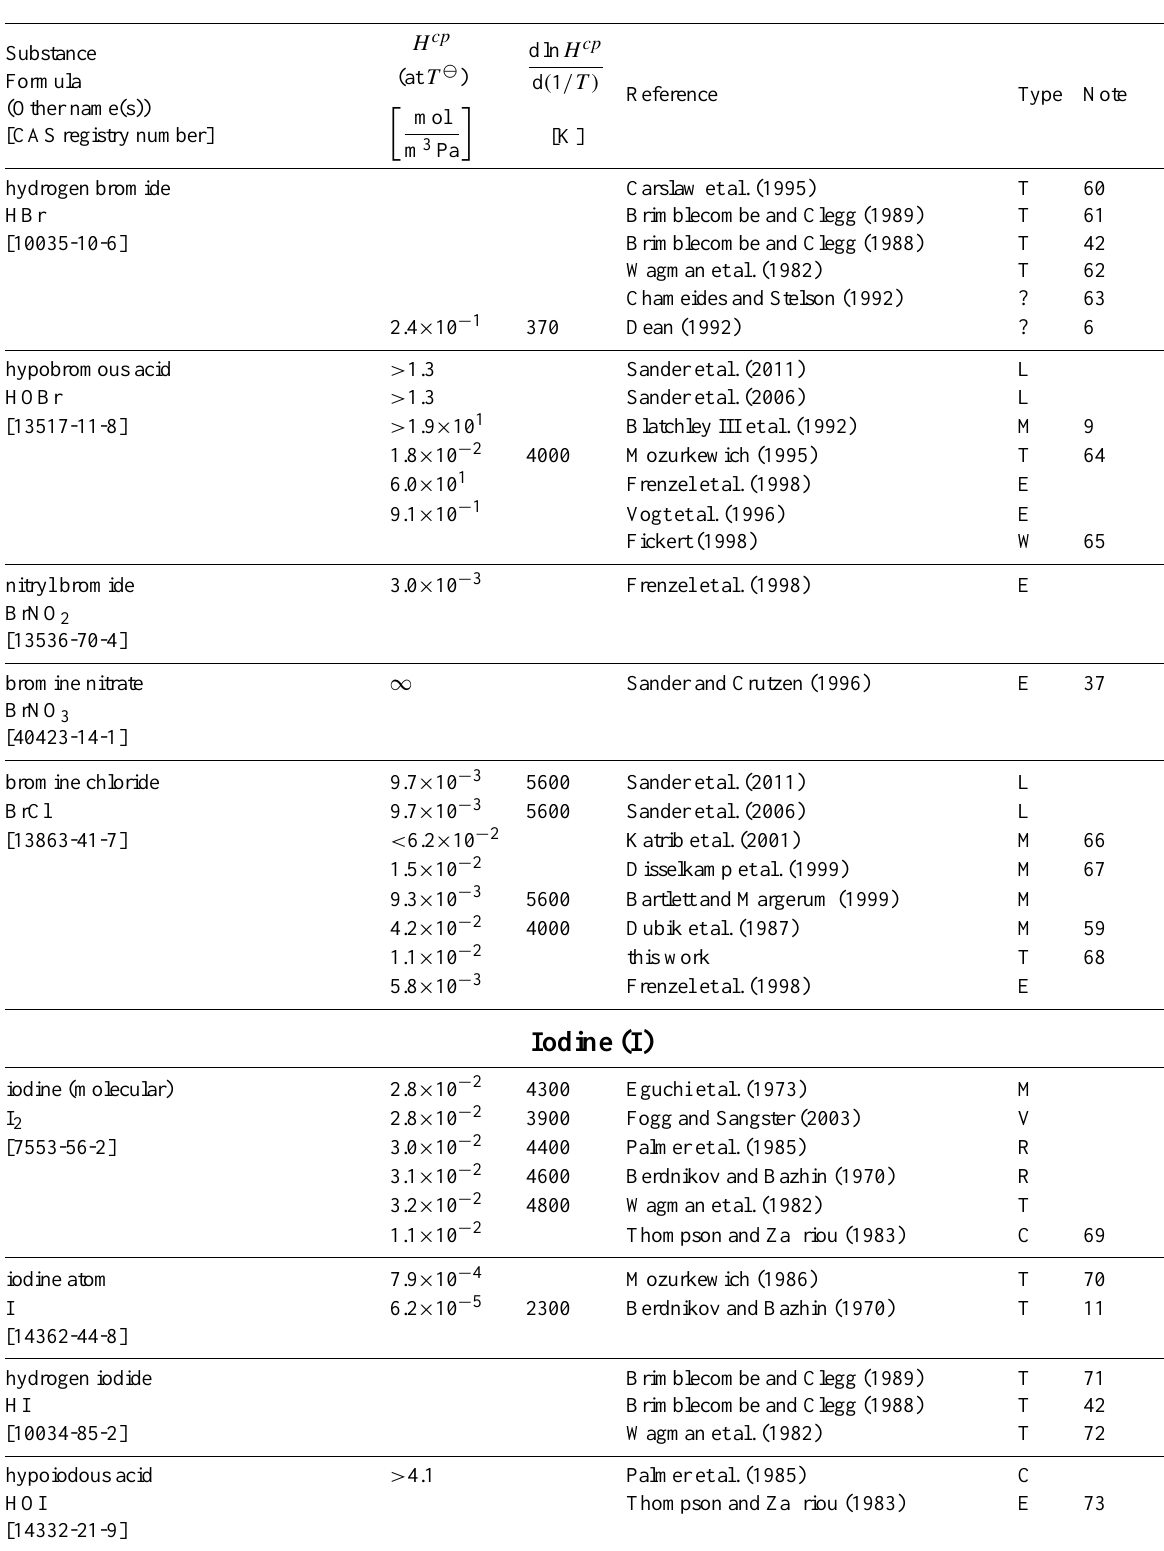
Table 6: Henry’s law constants for water as solvent